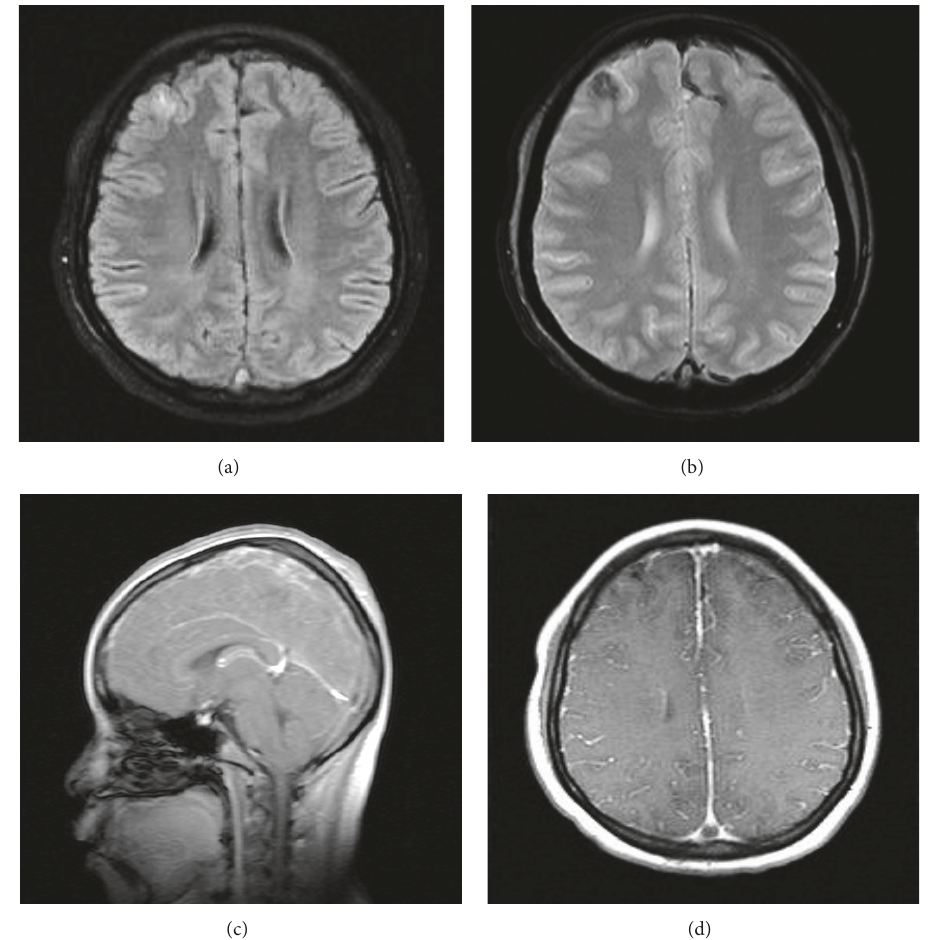
Figure 1: Initial MRI brain of our patient with and without contrast showed right frontal hyperintensity on FLAIR (a) with corresponding area on gradient echo (b), suggestive of a small intraparenchymal hemorrhage. GRE also showed decreased signal of two frontal cortical veins (b). Sagittal T1 imaging (c) revealed heterogeneous signal of the superior sagittal sinus. Postcontrast images were remarkable for a filling defect with direct visualization of the thrombus (d) in the superior sagittal sinus.